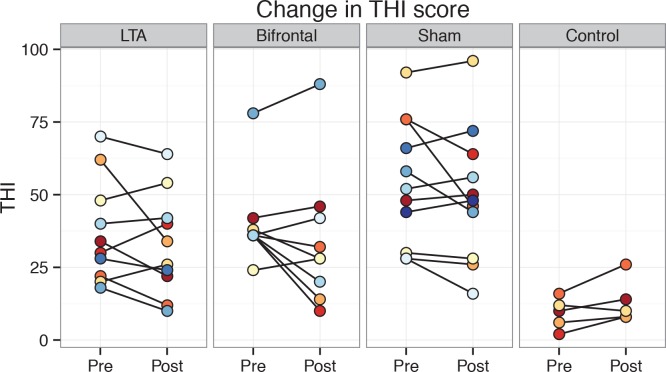
Individual THI scores pre- and post-treatment shown group-wise.